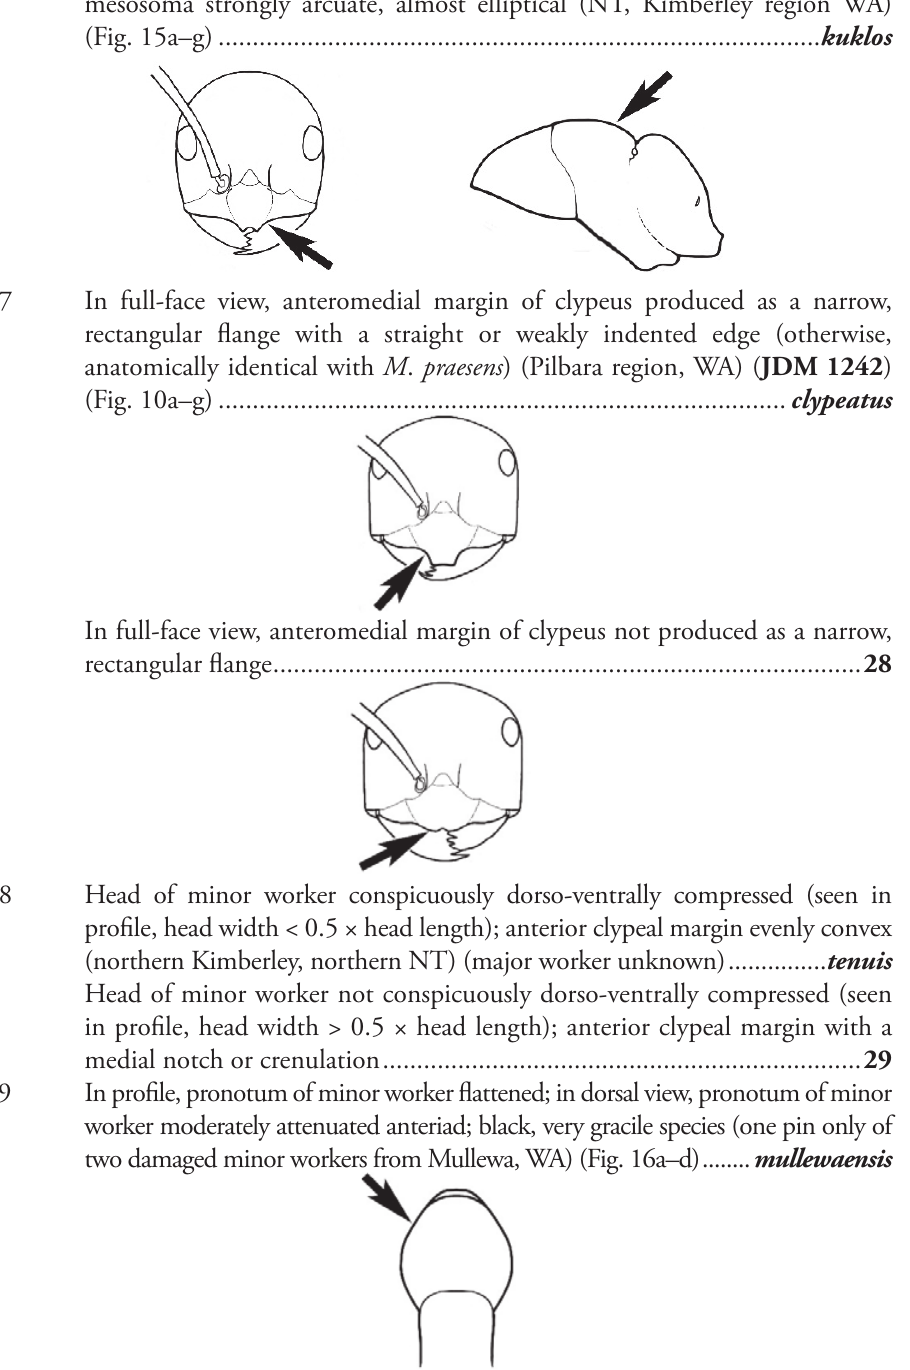
distinctly notched or even forked at its midpoint; dorsum of minor worker mesosoma strongly arcuate, almost elliptical (NT, Kimberley region WA) (Fig. 15a–g) ........................................................................................ kuklos